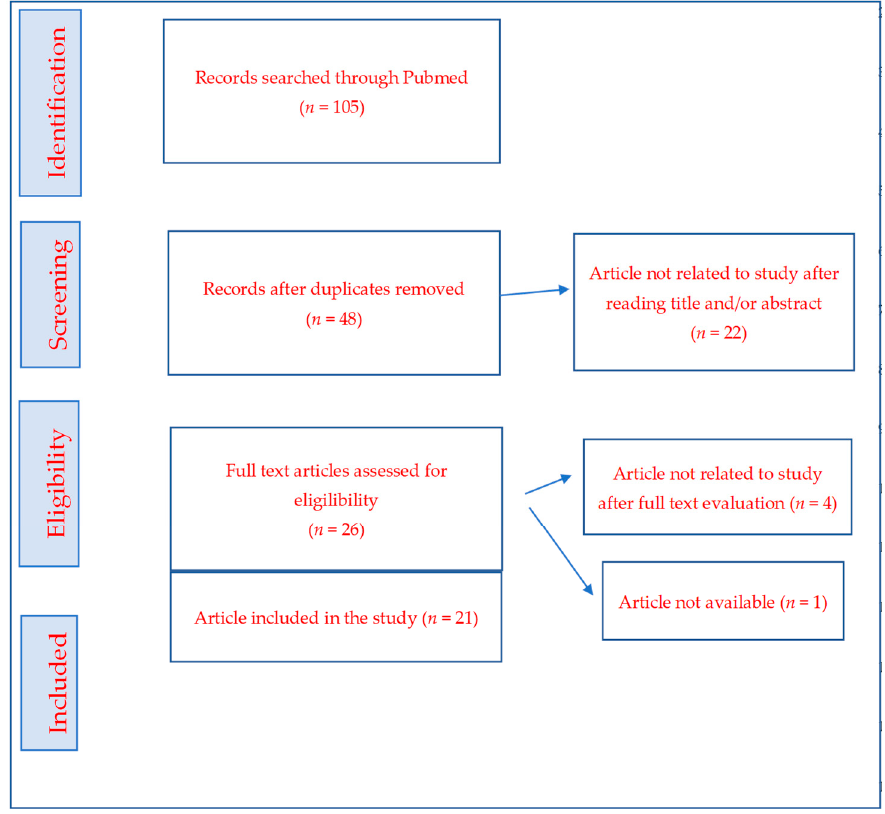
Figure 1. PRISMA flowchart of the selected studies, with criteria and numbers of studies. Table 1. Eligible articles based on inclusion criteria.